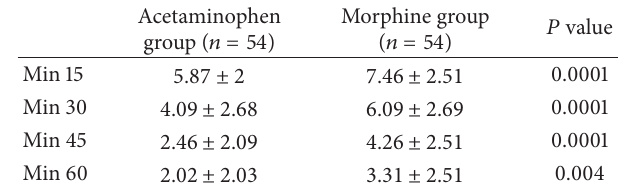
Table 2: Mean ± SD of VAS in two groups across the